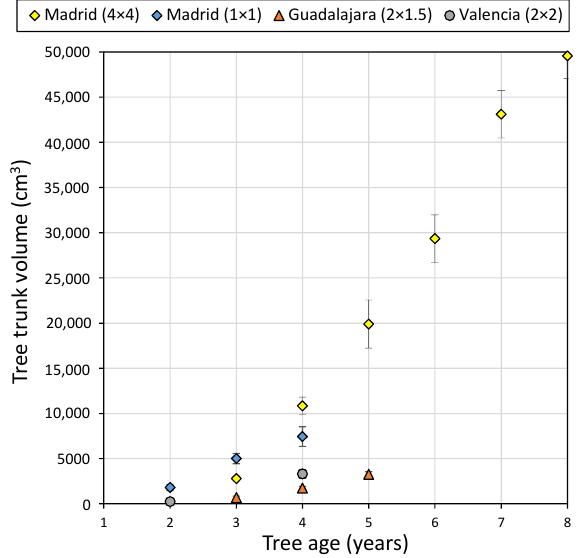
Figure 2. Tree trunk volume estimation for each tree age and experimental plot of Ademuz elm clone. Trunk volume was through direct measurements of diameter at the base and tree height. Vertical bars indicate standard errors.